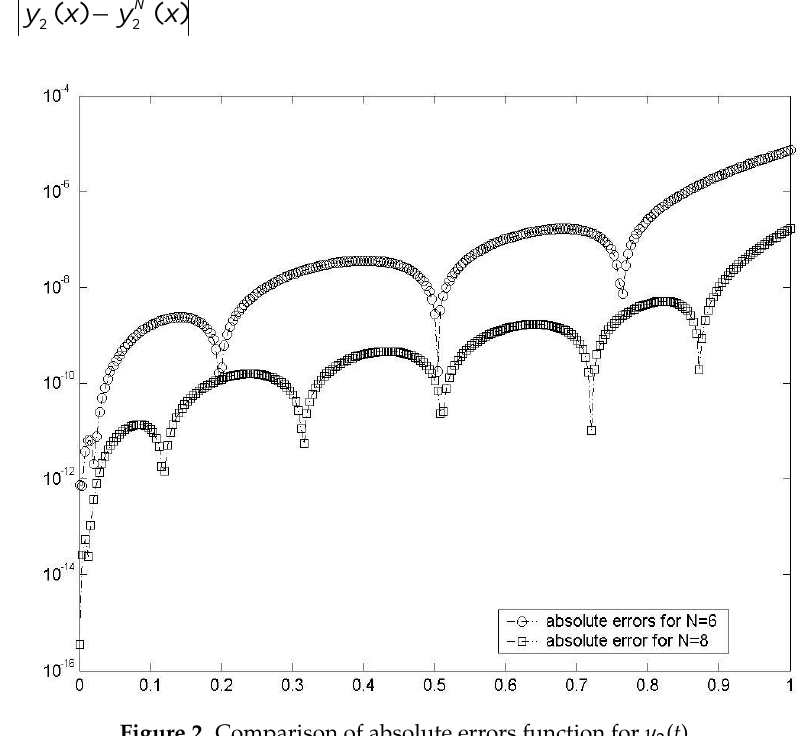
Figure 2. Comparison of absolute errors function for y 2 ( t ).